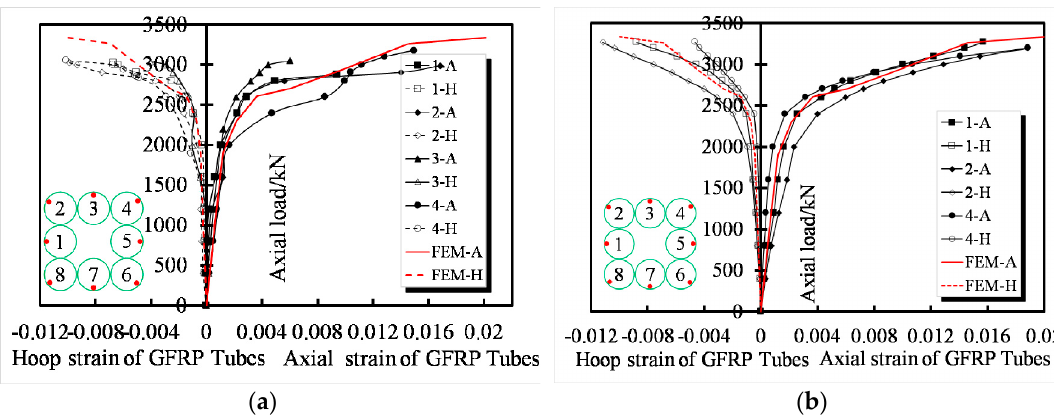
Figure 12. Comparisons of load–strain curves: ( a ) specimen T8N-1 and ( b ) specimen T8N-2.